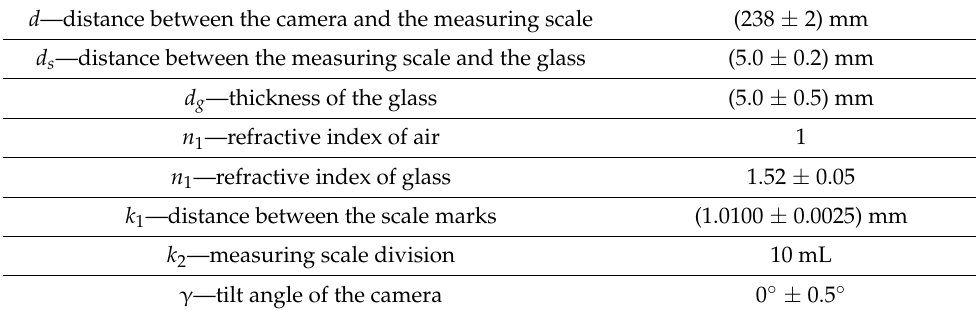
Table 1. Parameters of the experimental setup and their estimated uncertainties ( k =